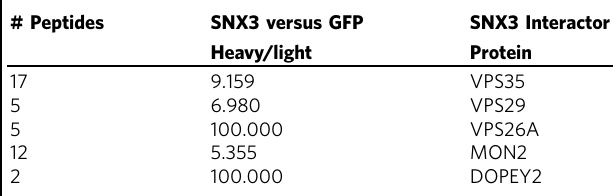
Table 1 Fold enrichment and number of peptides detected for components of the retromer and MON2 and DOPEY2 in the SNX3